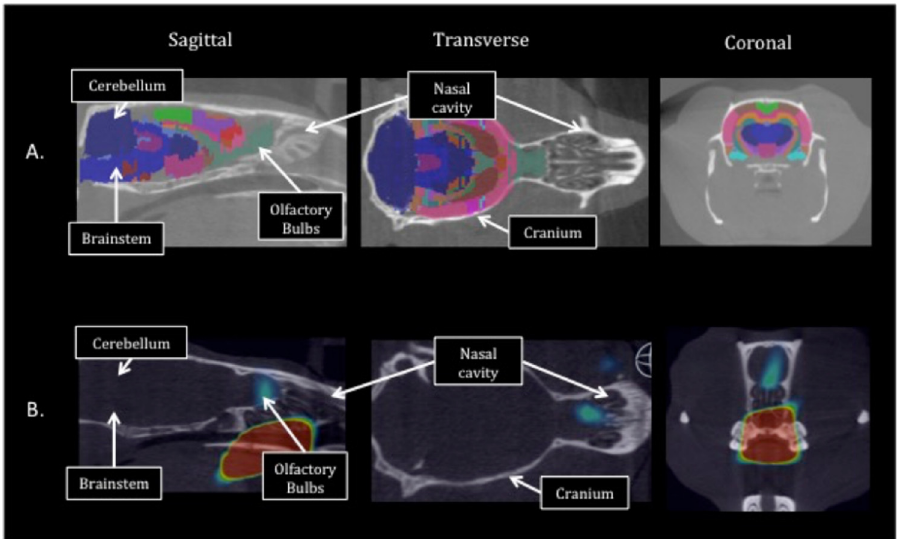
Figure 2. PET/CT image segmentation and labeling for brain subregion definition. The 3D regions of interest were defined for the brain subregions based on the Paxinos and Watson rat brain atlas. A total of 13–64 brain regions and subregions were defined using this automated software. Sagittal, horizontal, and coronal CT images ( A ) through the rat brain with the corresponding PET/CT images ( B ) for the same animal are shown. Example brain regions that were analyzed include the olfactory region, hypothalamus, septal region, amygdala, hippocampus, cortex, thalamus, brainstem, ventricles, cerebellum, and rostral spinal